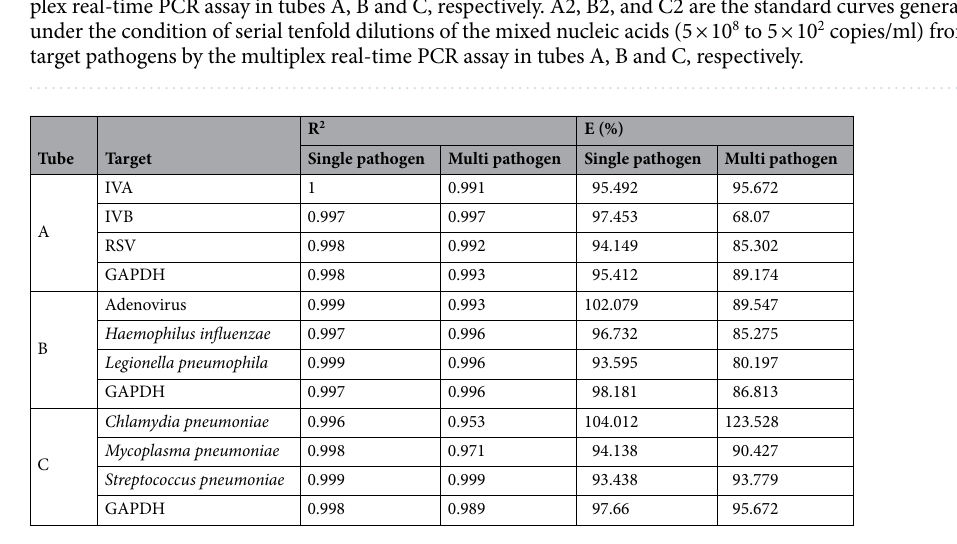
Table 1. The values of R 2 and E for the target pathogens analysed in the three-tube multiplex real-time PCR.